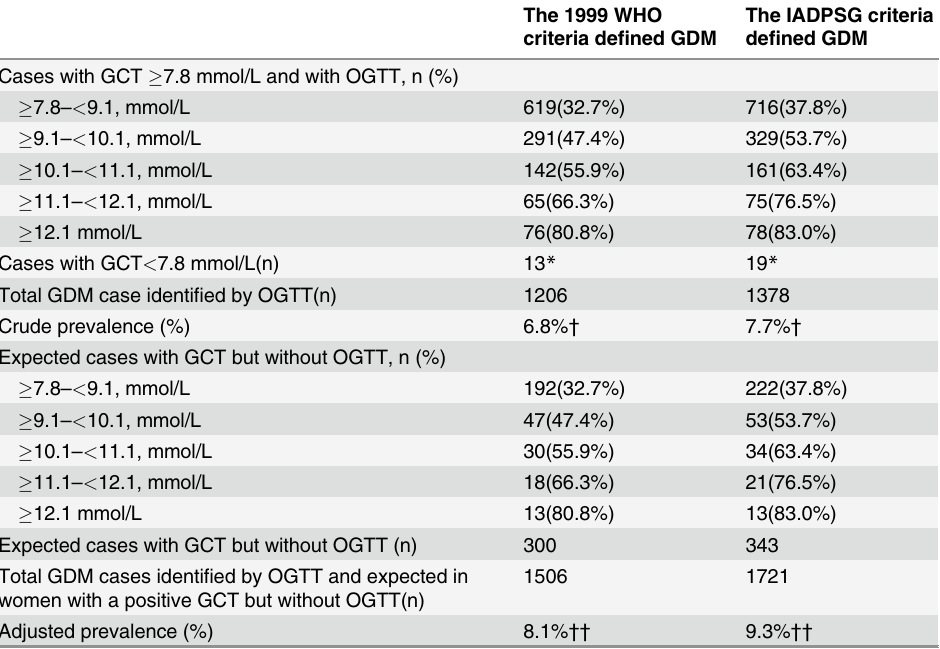
Table 1. Prevalence of gestational diabetes diagnosed by the 1999 WHO criteria and the IADPSG criteria.